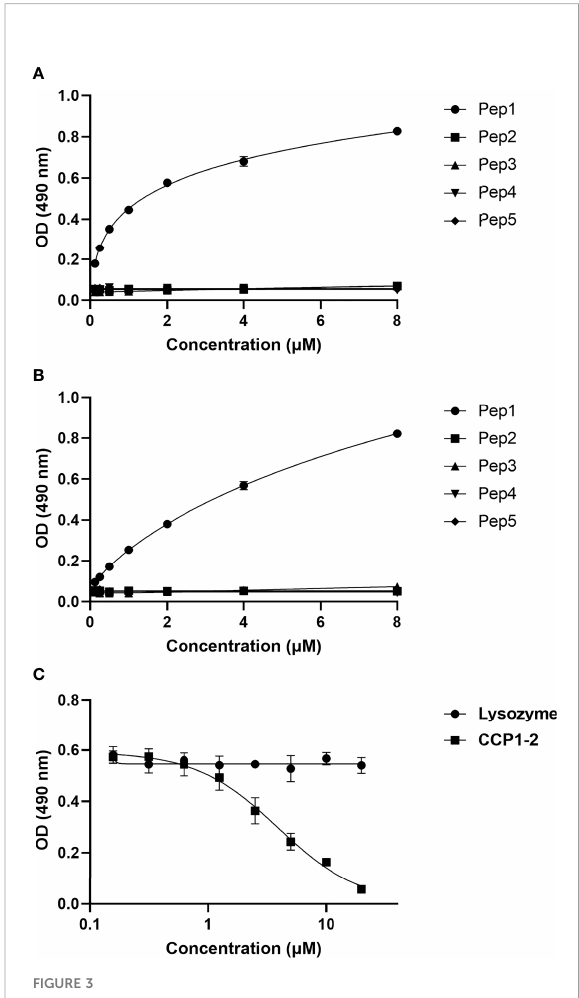
FIGURE 3 Binding of CSP biotinylated peptides to C4bp and CCP1-2 domains of the C4bp a -chain. (A) Binding of CSP Pep1, 3 and 5 (representing the 3 positive binding signals observed in the peptide array analysis) and Pep2 and 4 (negative control peptides) to C4bp. (B) Binding of the CSP peptides to CCP1-2 domains. (C) Inhibition of Pep1 binding to C4bp by CCP1-2